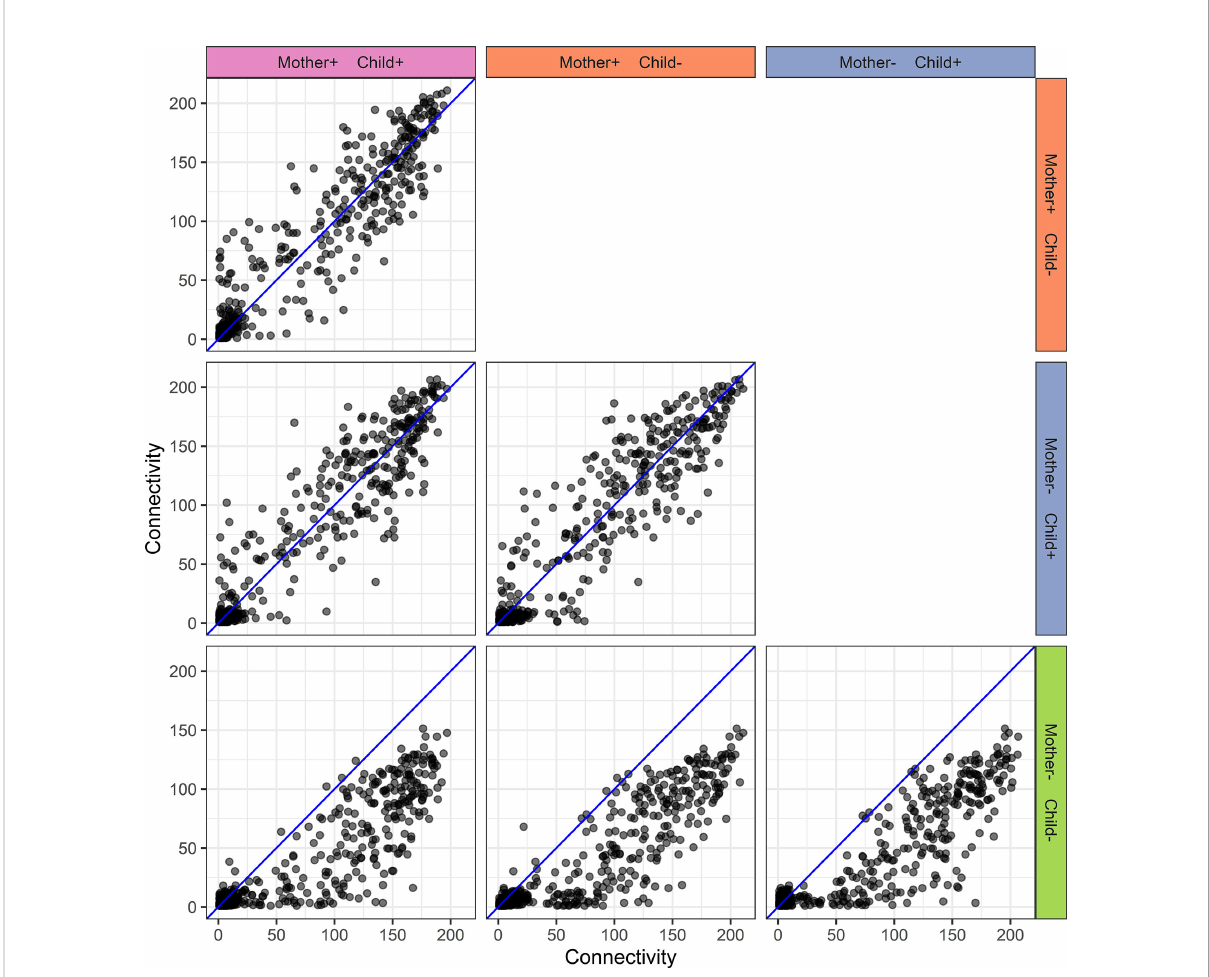
FIGURE 6 Human milk protein connectivity in the different mother-child allergy groups from the CHILD Cohort Study. Each subplot represents a pairwise comparison of protein connectivity in two mother-child allergy groups and each dot represents a single protein. Protein connectivity is obtained from the adjacency matrices build with the PCLRC algorithm and all groups are compared with one another in each subplot. In the labeling of the groups, + indicates allergy and - indicates no allergy. The group in which both mother and child are non-allergic shows a distinct connectivity pattern with an overall lower connectivity of the